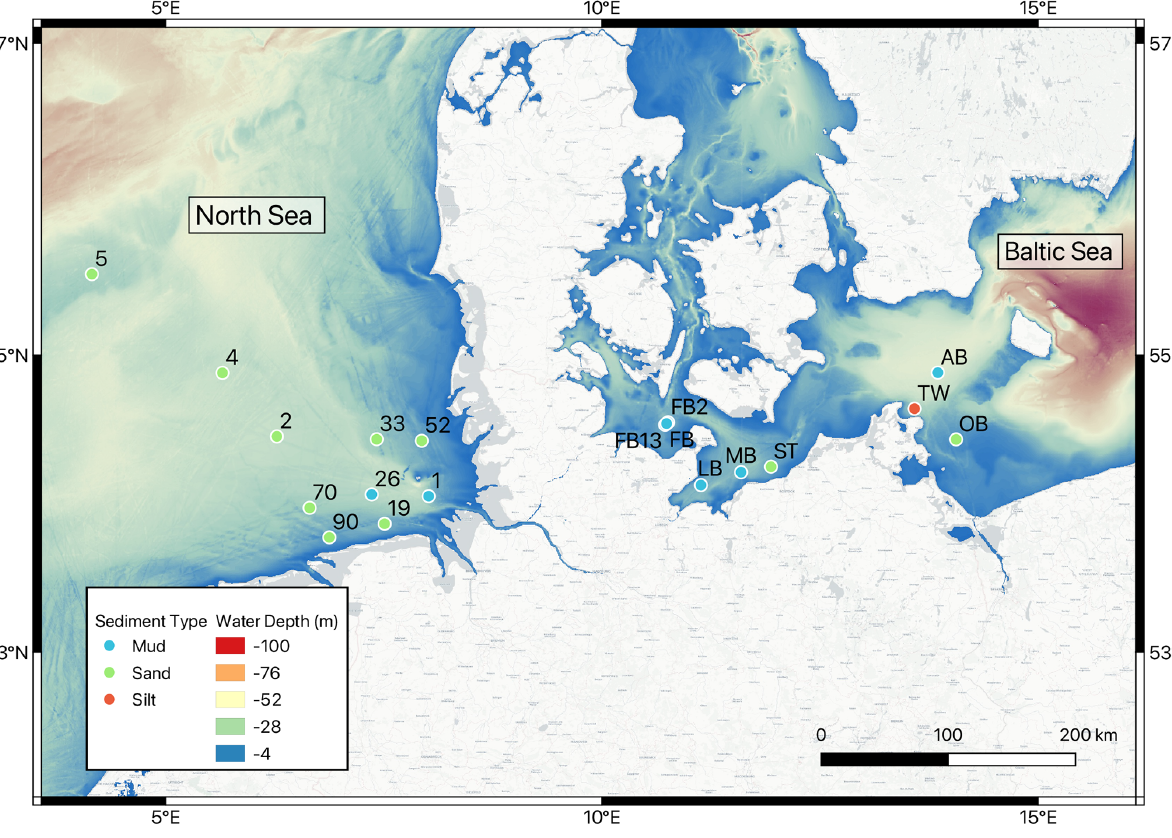
Figure 1. Map of sampled stations, with points colored by sediment